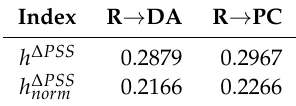
Table 2. Herfindahl-Hirschman Index (HHI) and normalised HHI for both alternative